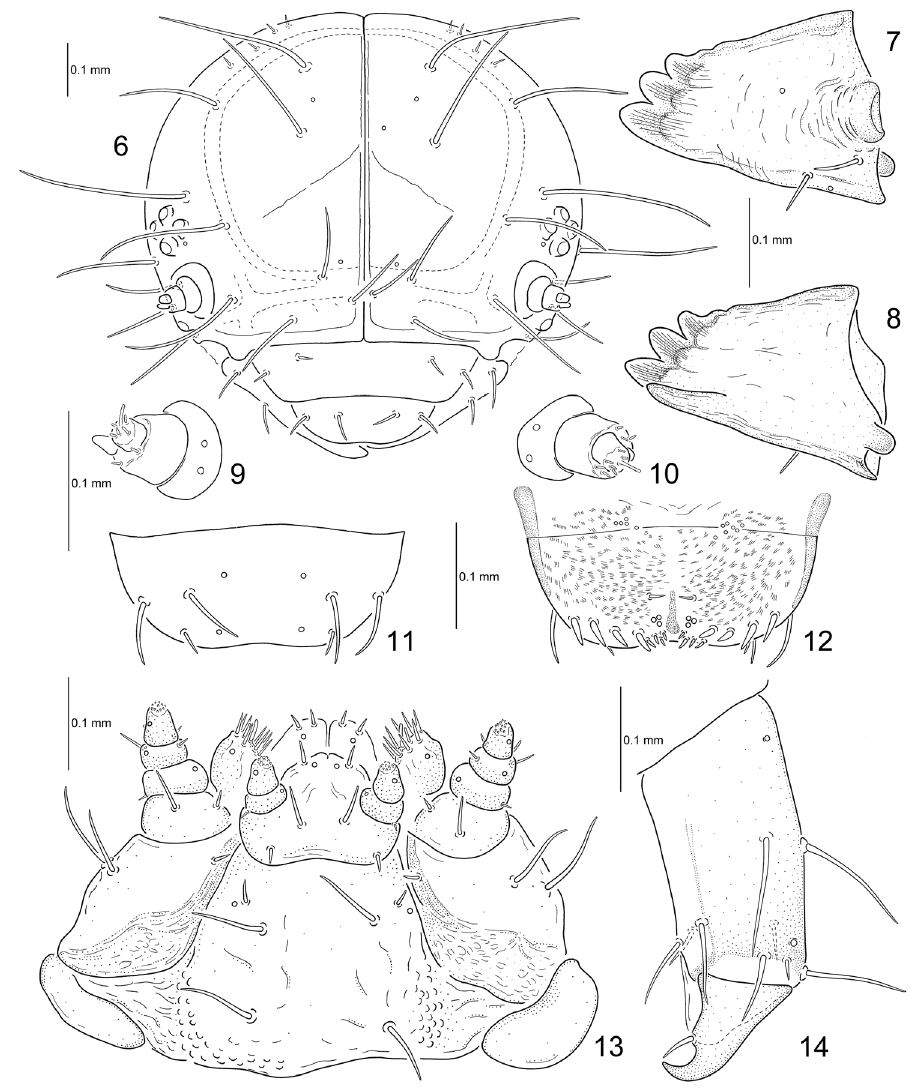
Figures 6–14. Phratora koreana , third instar larva. 6 head 7–8 mandibles 9–10 antennae 11 labrum 12 epipharynx 13 maxillae and labium 14 tibia and tarsungulus. Abdomen . Segments I–VI with Dai (1S) very small; Dp (2L 1S) small, but larger than Dai; DL (2L 1M) conical with a defensive gland; EP (2L) and P (2S) not scle- rotized; PS-SS (3S) and ES (1S) represented by setae. Segment VII with dorsal tubercles enlarged and fused; DL with a defensive gland. Segments VIII–IX each with dorsal and dorso-lateral tubercles fused. Segment X with pygopod well developed. Spiracles present on segments